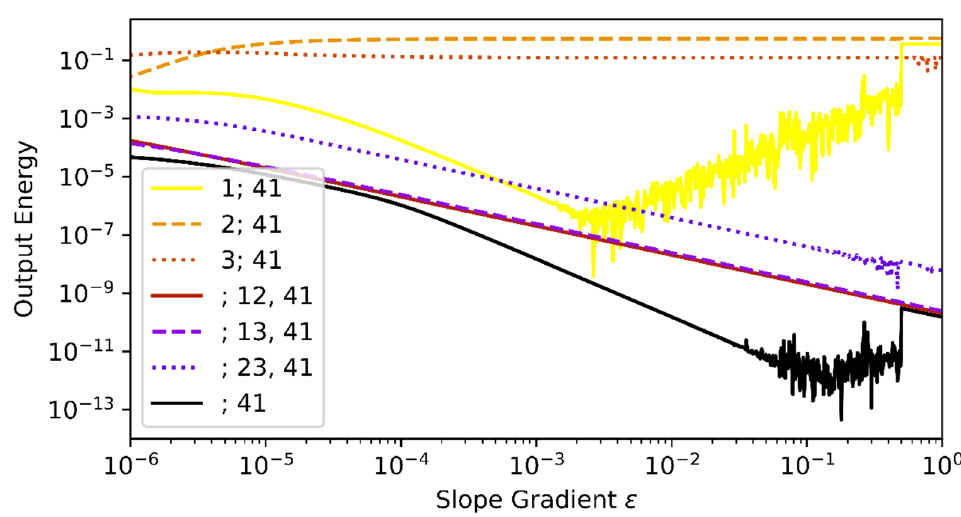
Figure A1. Effect of assumption of relative flow gradient 𝜀 on the Output Energy.